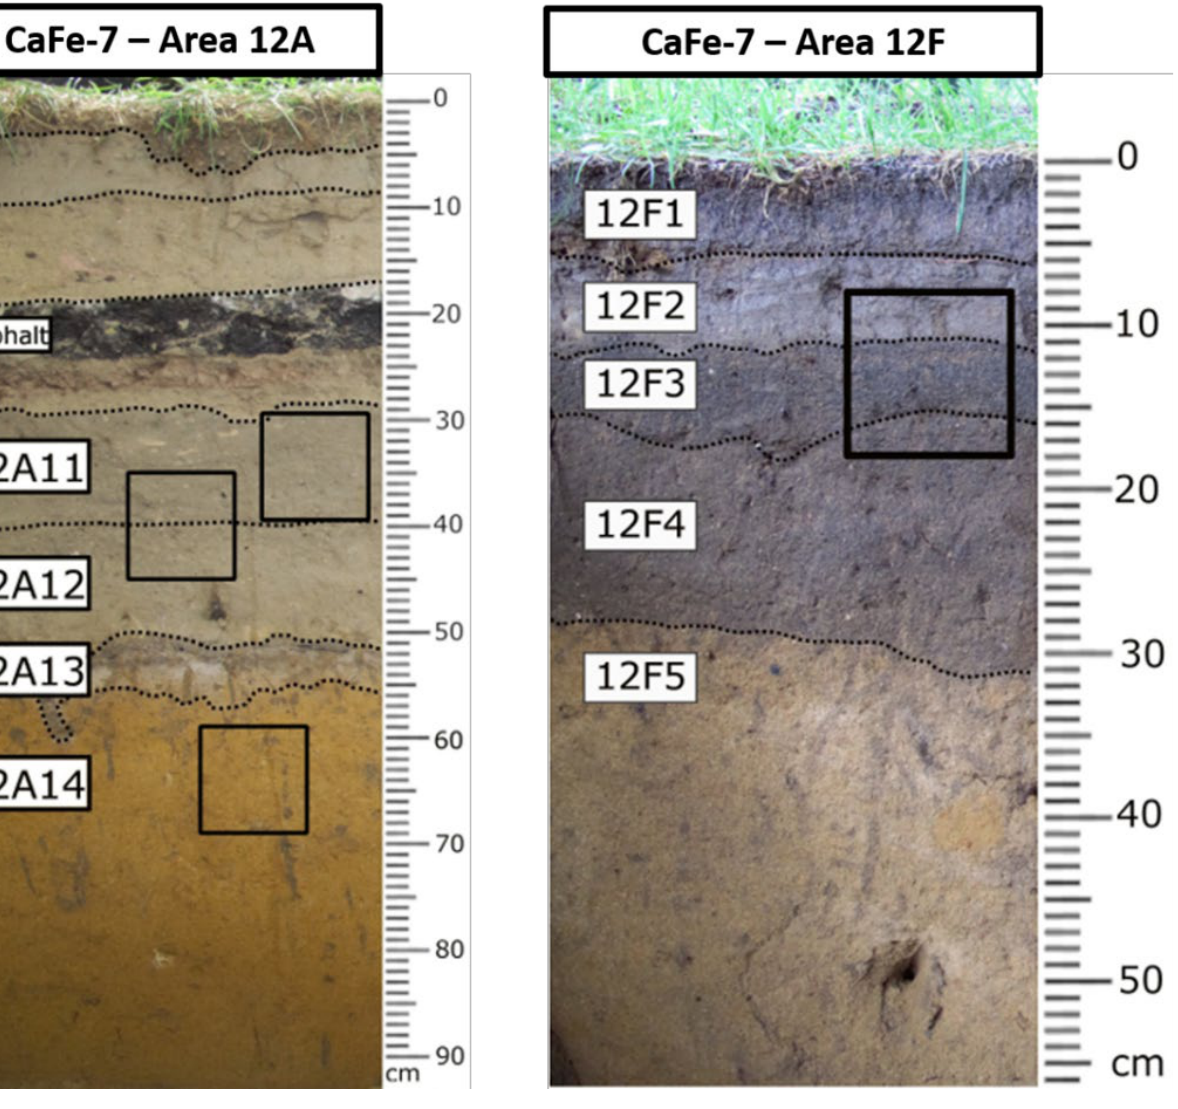
Figure 3. Sediment layers sampled in areas 12A and 12F of the Fort Odanak site (CaFe-7). Squares represent the approximate position of the kubiëna boxes used in sampling.